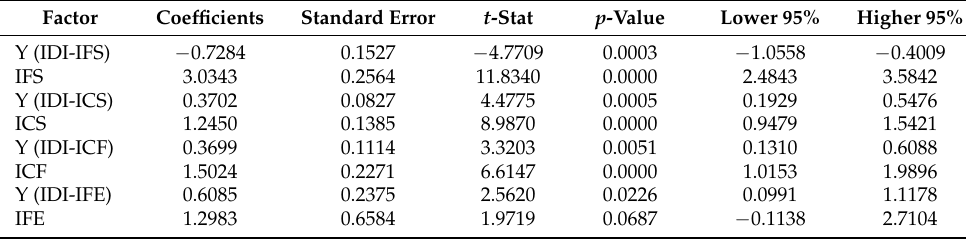
Table 6. Multiple regression model results for textile companies under